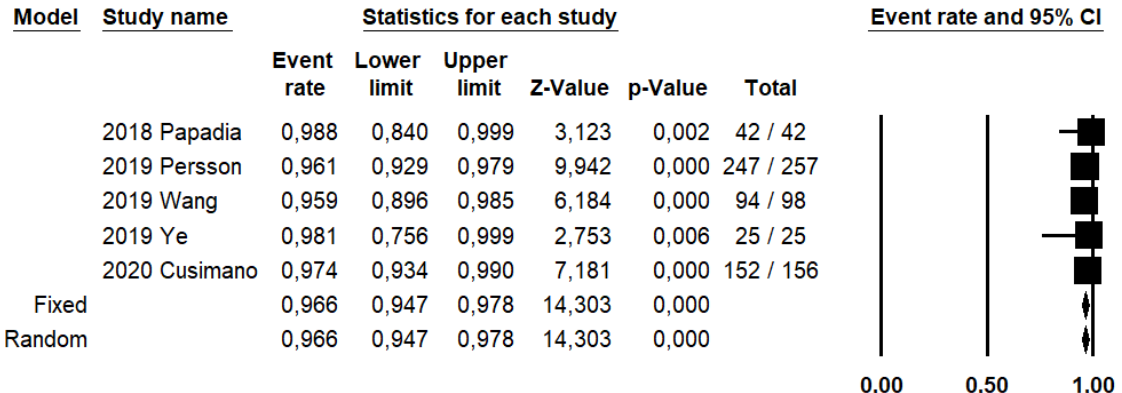
Figure 5. Forest plots of individual studies and pooled bilateral detection rate of sentinel lymph node. 4. Discussion 4.1. Main Findings and Interpretation This study shows that SLN biopsy through the cervical injection of ICG has a high sensitivity in detecting EC metastasis in high-risk groups of early-stage EC patients. Moreover, such technique has a low FN rate and high DRh, DRp and DRb. SLN biopsy emerged in order to reduce peri-operative morbidity and long-term lymphatic complications of systematic lymphadenectomy, and to overcome technical difficulties in performing the procedure. The first successful case of SLN biopsy was historically described in 1977, with a lymphangiography of the penis. [34] Since then, SLN biopsy techniques have been studied and developed for several solid malignancies, among them, breast cancer and melanoma [35,36]. In gynecologic oncology, SLN biopsy first reached agreement for patients with vulvar cancer. Subsequently, it was also encouraging in the management of cervical and ECs [10]. In fact, since 2014, the National Comprehensive Cancer Network (NCNN) approved SLN biopsy as an alternative to systematic lymphadenectomy for the staging of apparent uterine-confined ECs in selected cases [12]. However, while feasibility and sensitivity in detecting EC metastasis was proven to be enough in low-risk EC patient groups [37], its